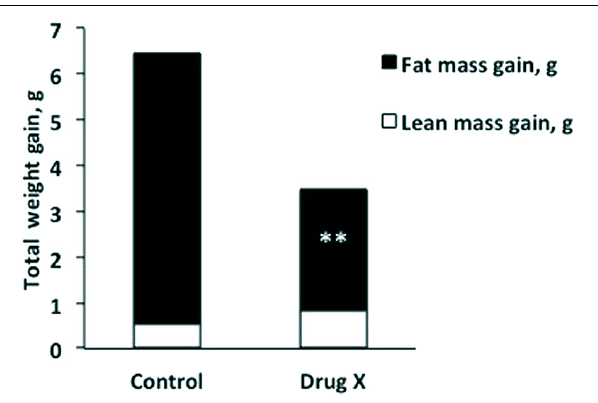
FIGURE 1 |Total weight gain broken down into lean mass gain (white) and fat mass gain (black) in mice after 2 weeks on a high-fat diet, with or without a drug that lowers plasma total cysteine (Drug X). The cysteine lowering drug halved fat mass gain without compromising lean mass. ** P <